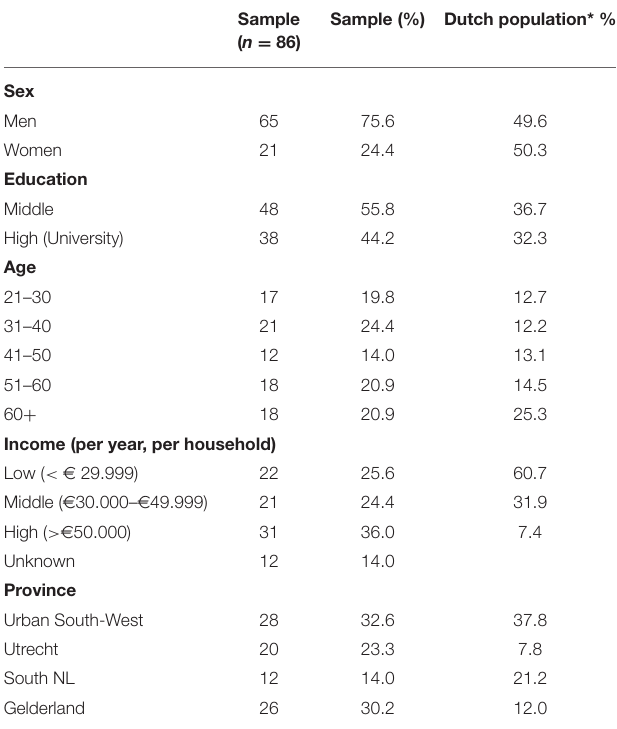
Table 2A | Socio-demographic characteristics of subset 1: Highly educated women.